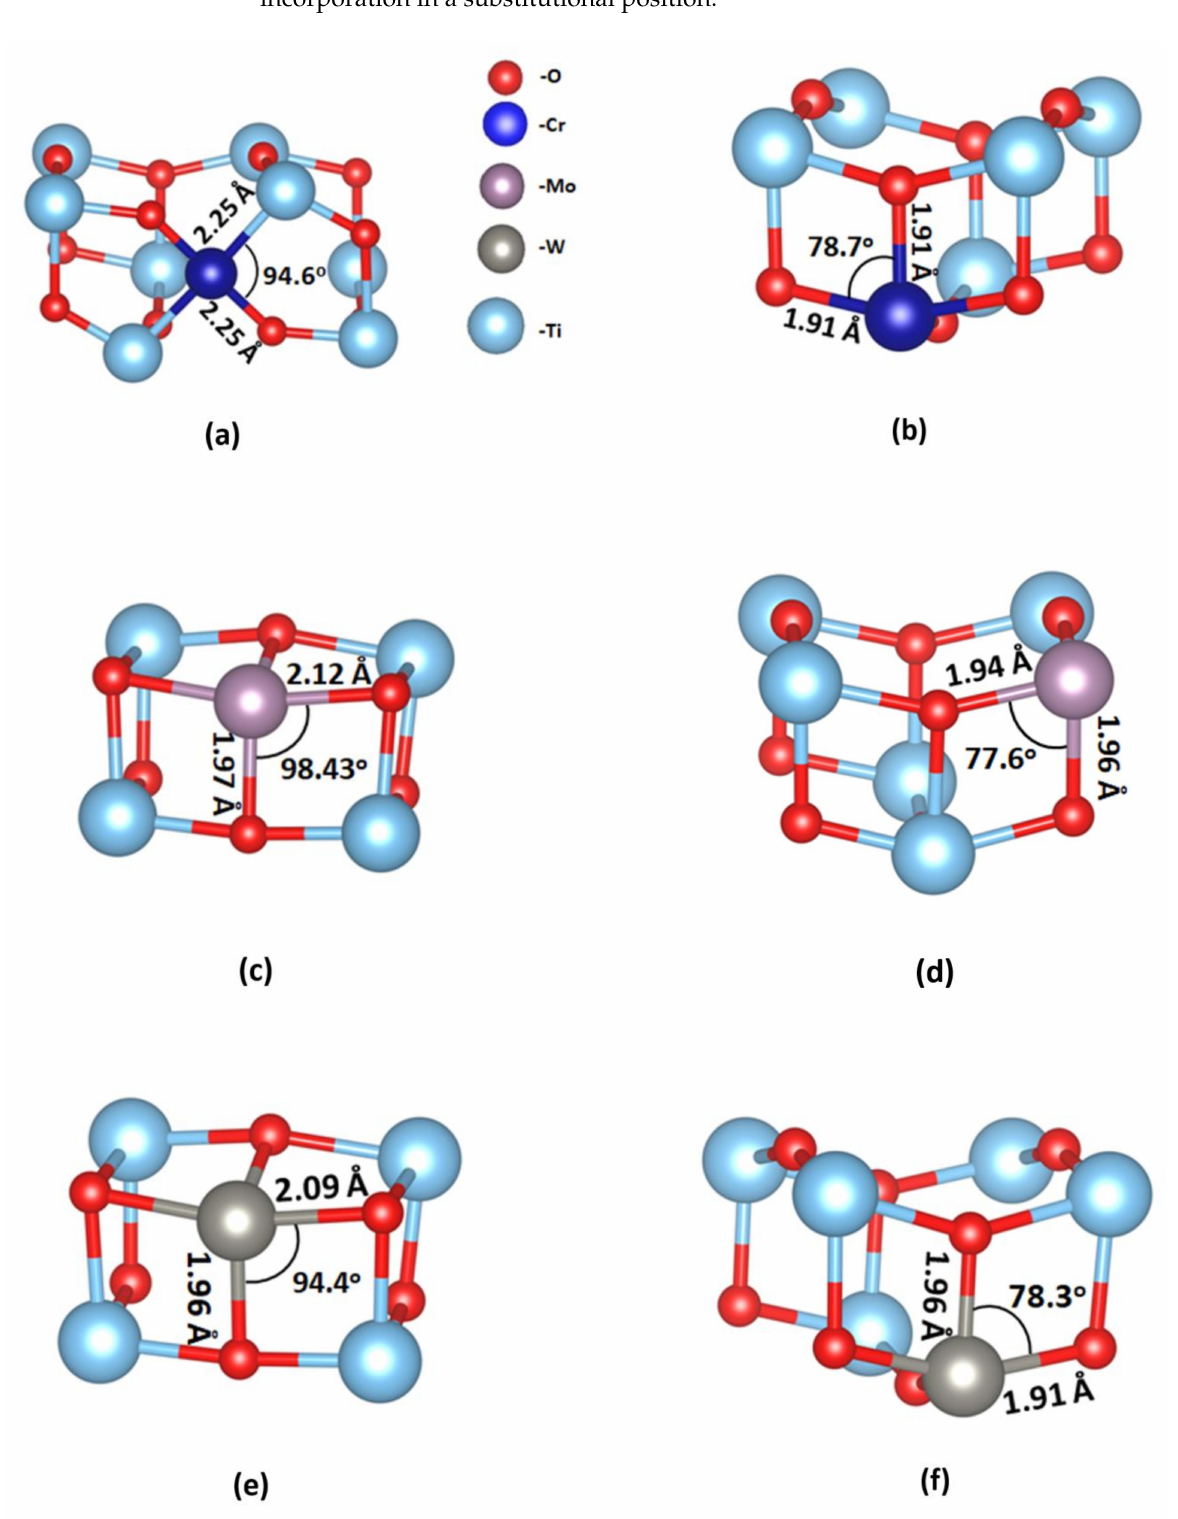
Figure 1. ( a ) Chromium (Cr) as an interstitial dopant, ( b ) Cr as a substitutional dopant, ( c ) molybdenum (Mo) as an interstitial dopant, ( d ) Mo as a substitutional dopant, ( e ) tungsten (W) as an interstitial dopant, ( f ) W as a substitutional